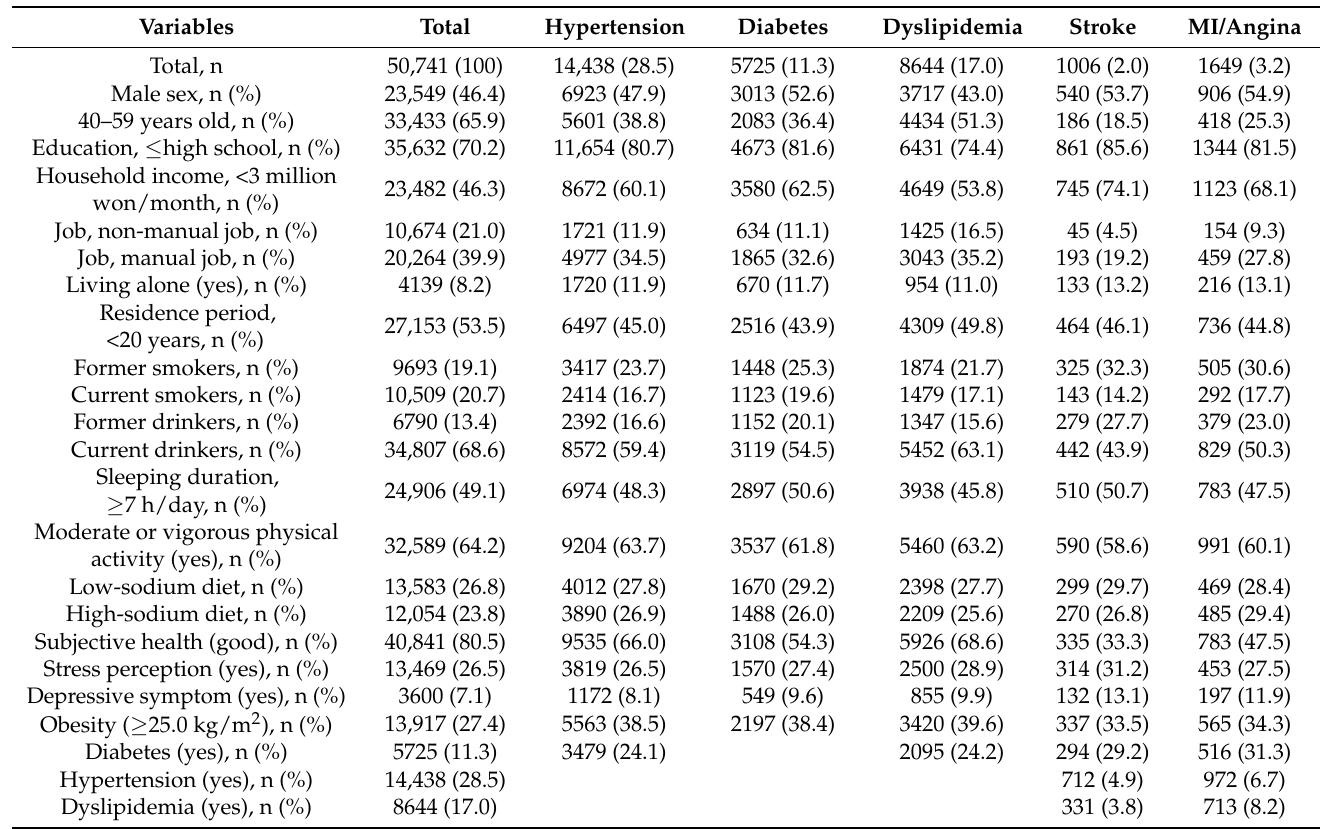
Table 2. Characteristics of study